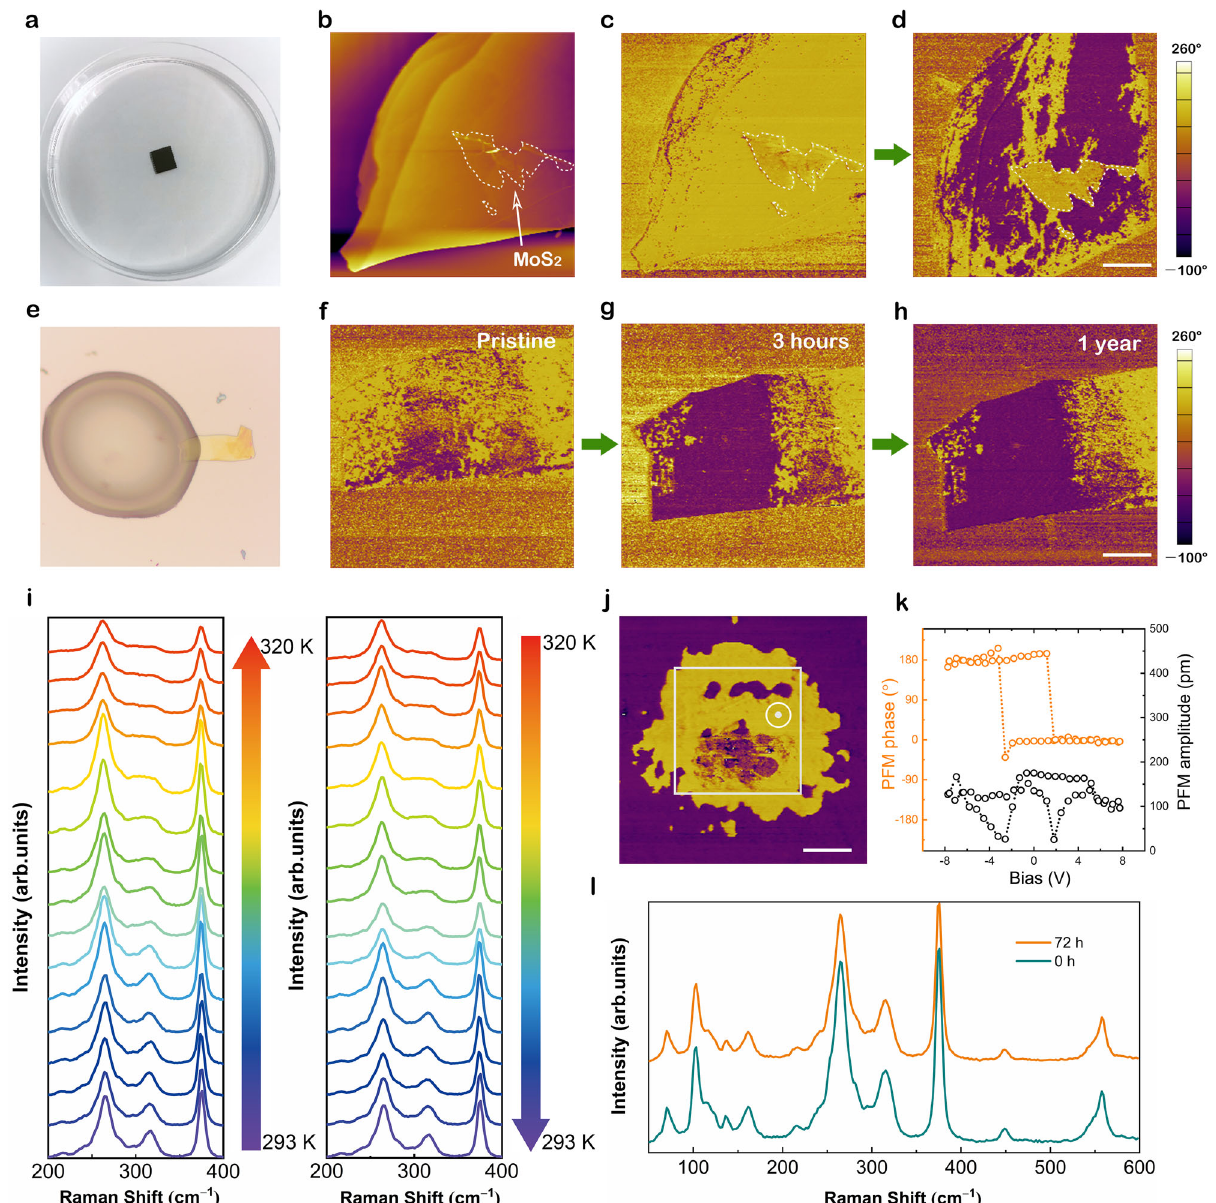
Fig. 2 Interfacial effect-induced polarization switching of layered CIPS. a Photograph of the ionic liquid treatment process. b The topography of a MoS 2 (4 nm)/CIPS (87 nm) heterojunction. c , d The PFM phase images before ( c ) and after ( d ) ionic liquid treatment. Scale bar in ( d ), 5 μ m. e Photograph of